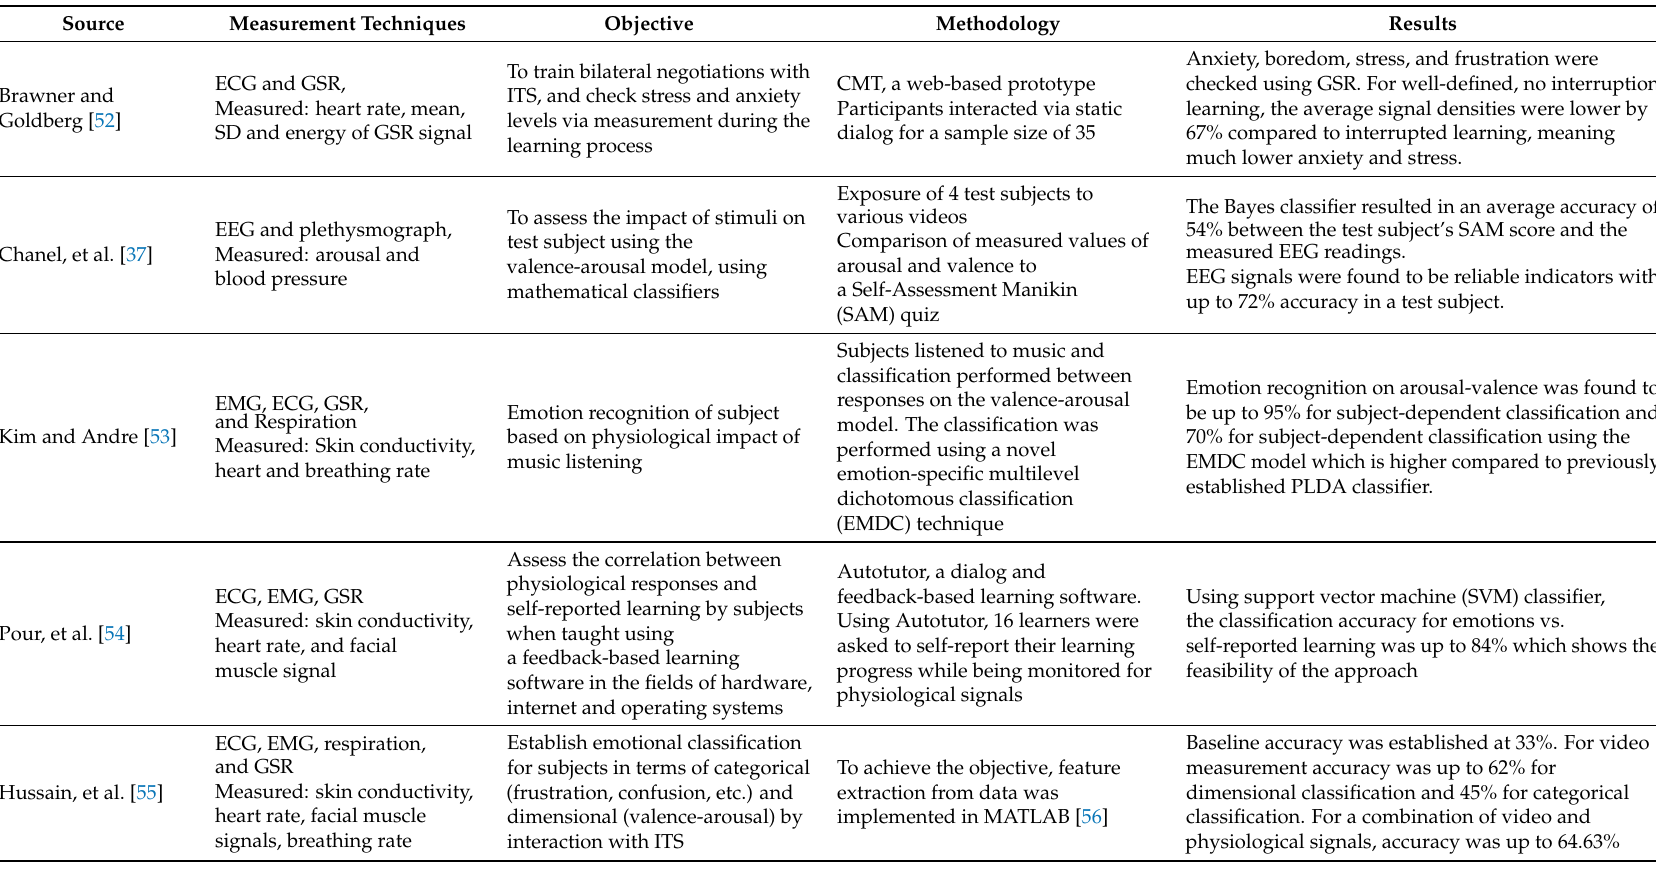
Table 1. Comparison and results of pre-existing physiological-based learning